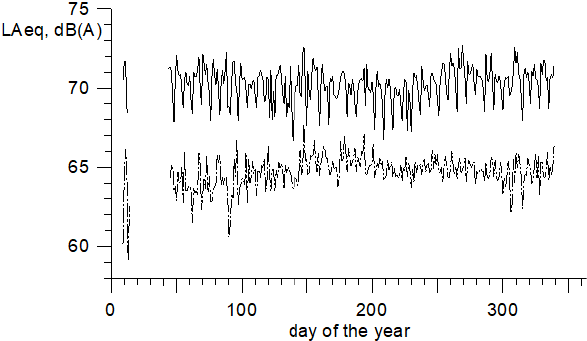
Figure 1: L Aeq calculated from measurements made at the location number 1, in year 2013, for: day sub-interval (6-18), (solid line), and night sub-interval (22-6), (dash-dot line)